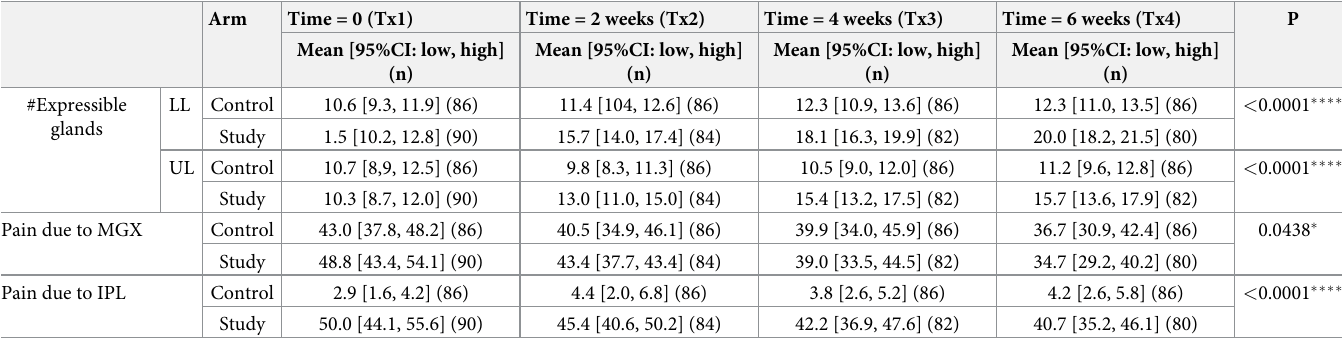
Table 4. Continuous outcome measures tested after every treatment